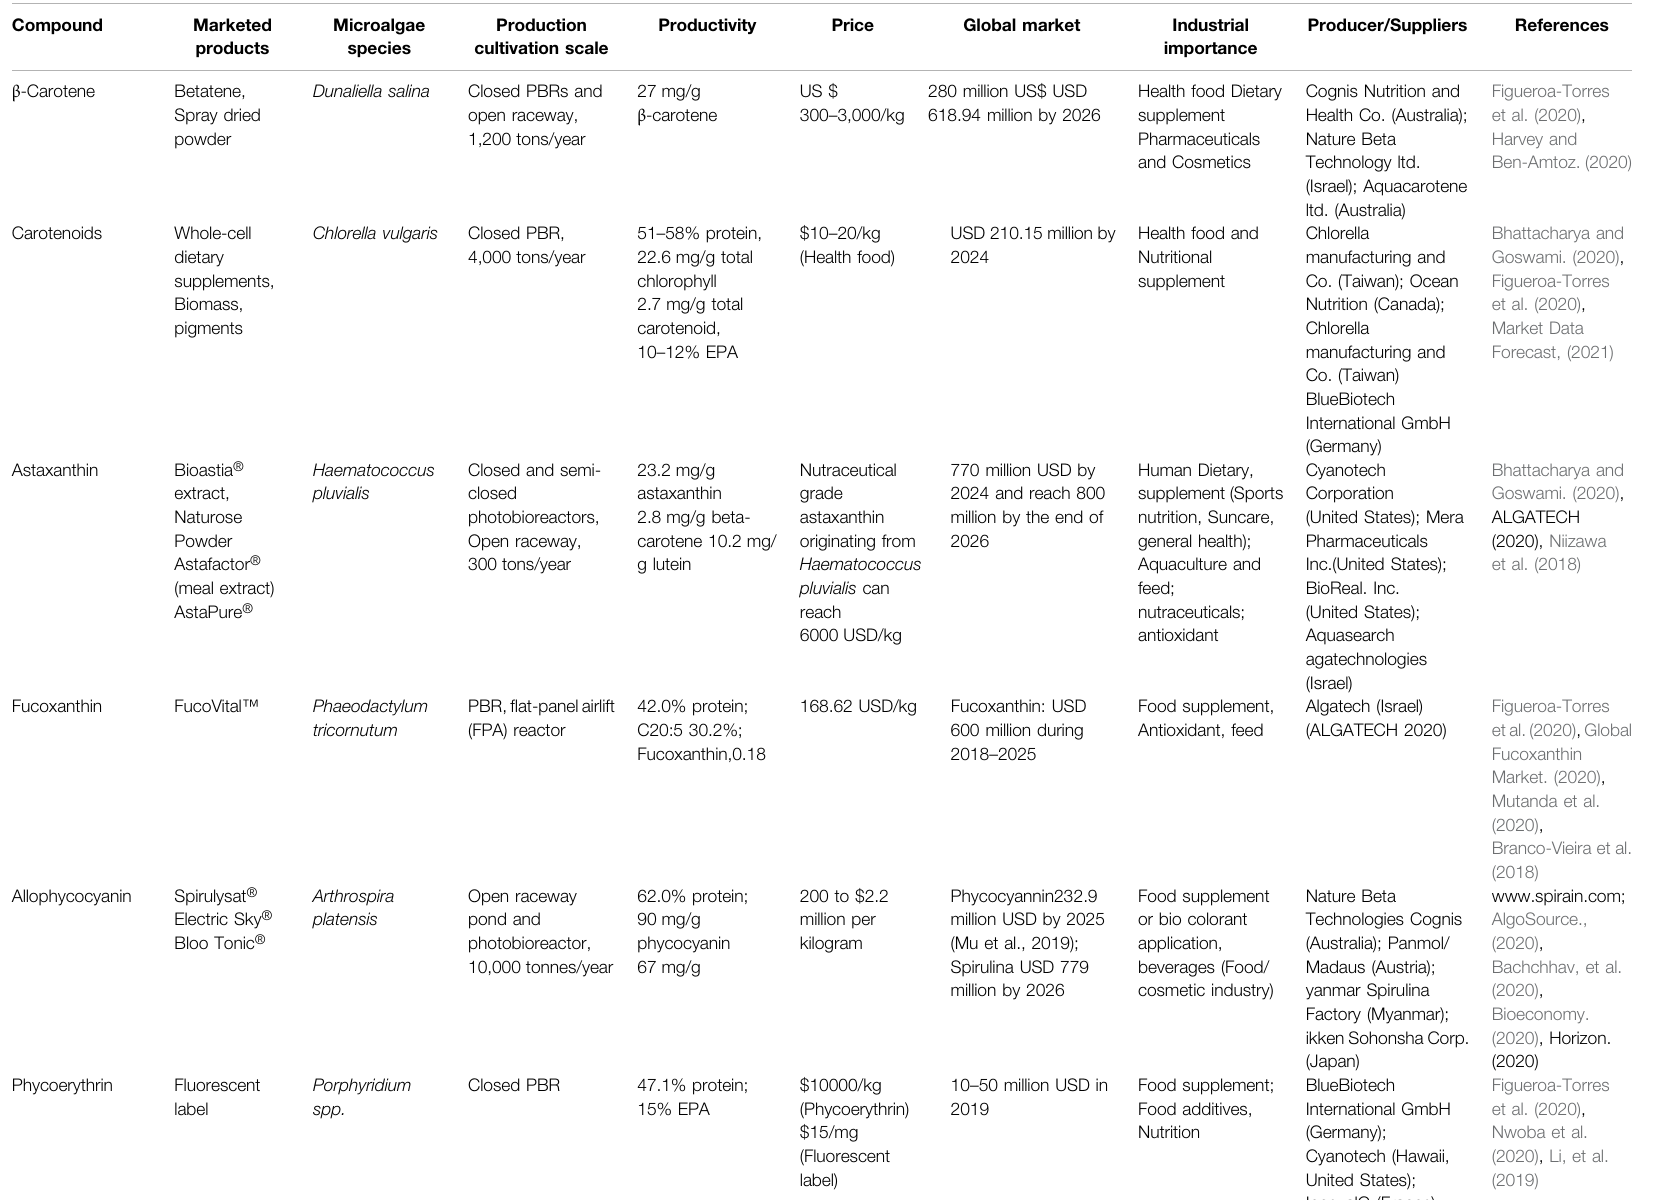
TABLE 3 | Microalgal products and their commercialization